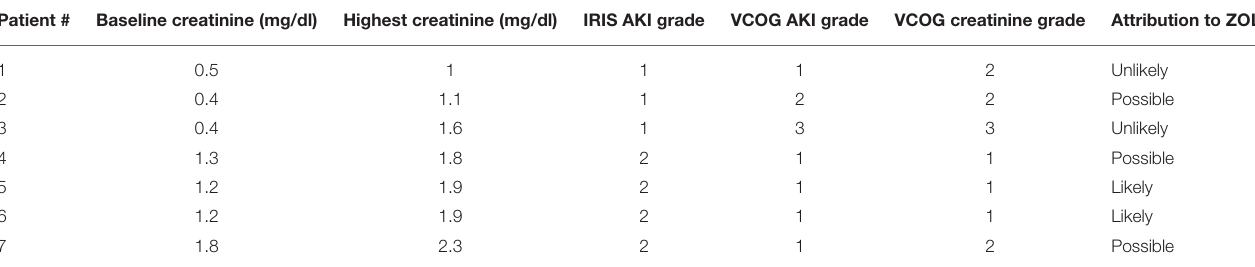
TABLE 2 | Variability in assessment of renal toxicity in seven dogs after initiation of zoledronic acid treatment using the International Renal Interest Society (IRIS) Acute Kidney Injury (AKI) and Veterinary Cooperative Oncology Group-Common Terminology Criteria for Adverse Events (VCOG-CTCAE) grading systems and assessment of likeliness of AKI to zoledronic acid